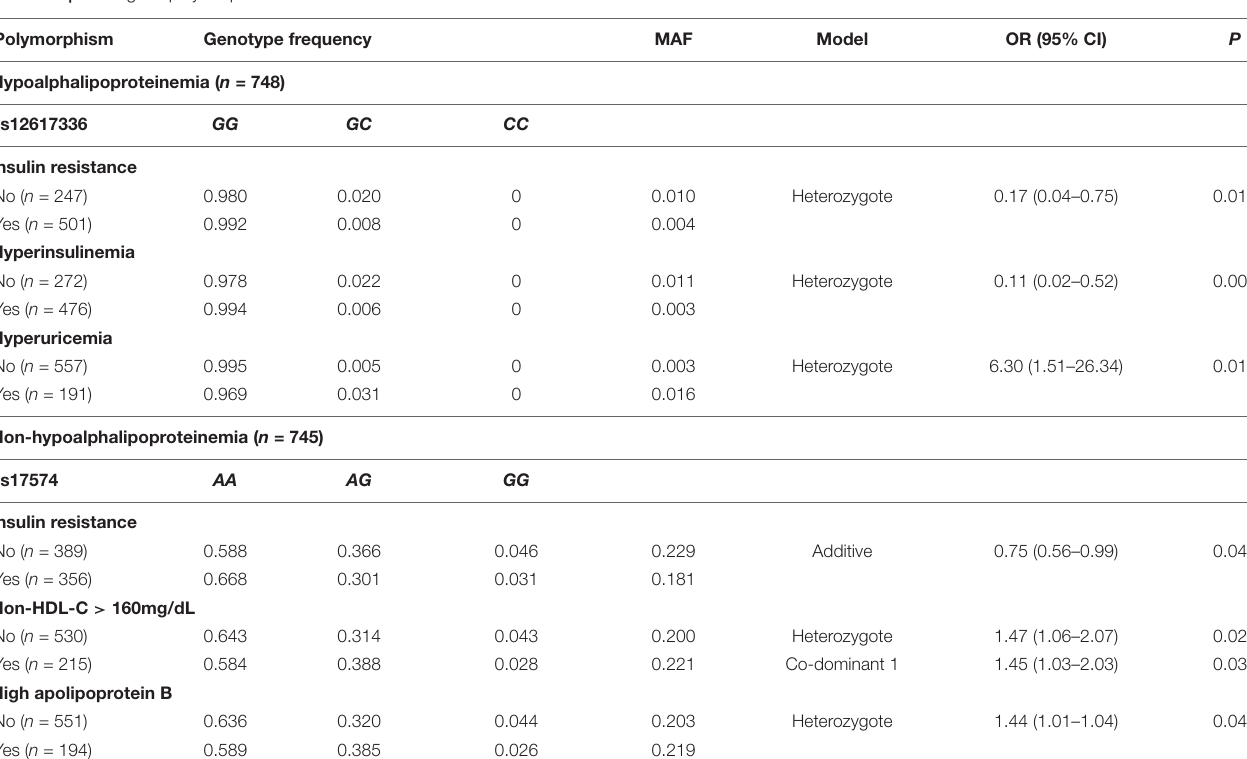
TABLE 2 | DDP4 gene polymorphisms association with cardiovascular risk